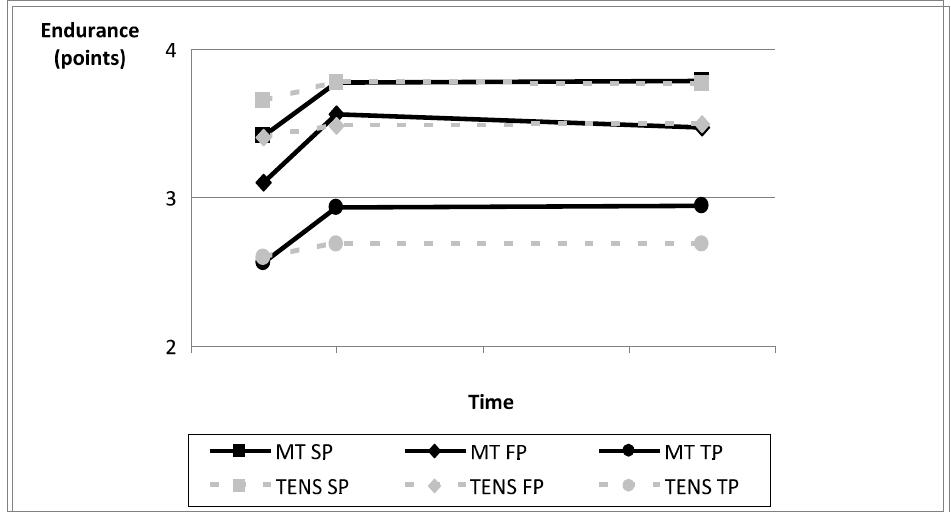
Figure 4. Endurance evolution by planes in both intervention groups. Abbreviations: SP, sagittal plane; FP, frontal plane; TP, transverse plane; MT, manual therapy; TENS, transcutaneous electric nerve stimulation.